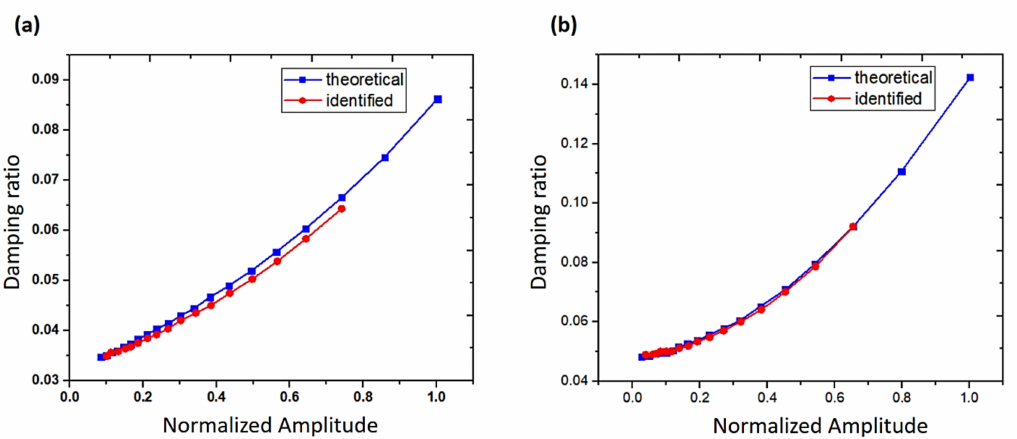
Figure 5. Curves of damping ratio versus amplitude. ( a ) Exponent relationship; ( b ) quadratic relationship [89].